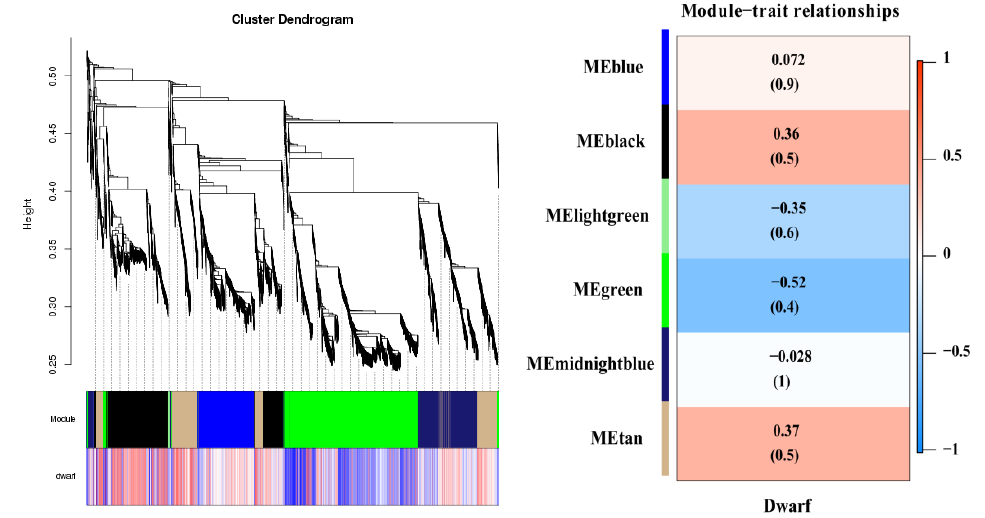
Figure 6. WGCNA analysis categorizes differentially expressed genes into six distinct gene modules and produces clustering results. (Analysis of the relationship between modules and dwarf phenotypes, numbers indicate correlation coefficients (kME) and p -values.).